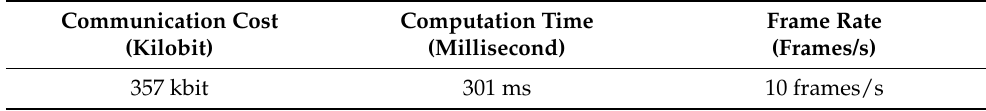
Table 2. The average communication cost and computation